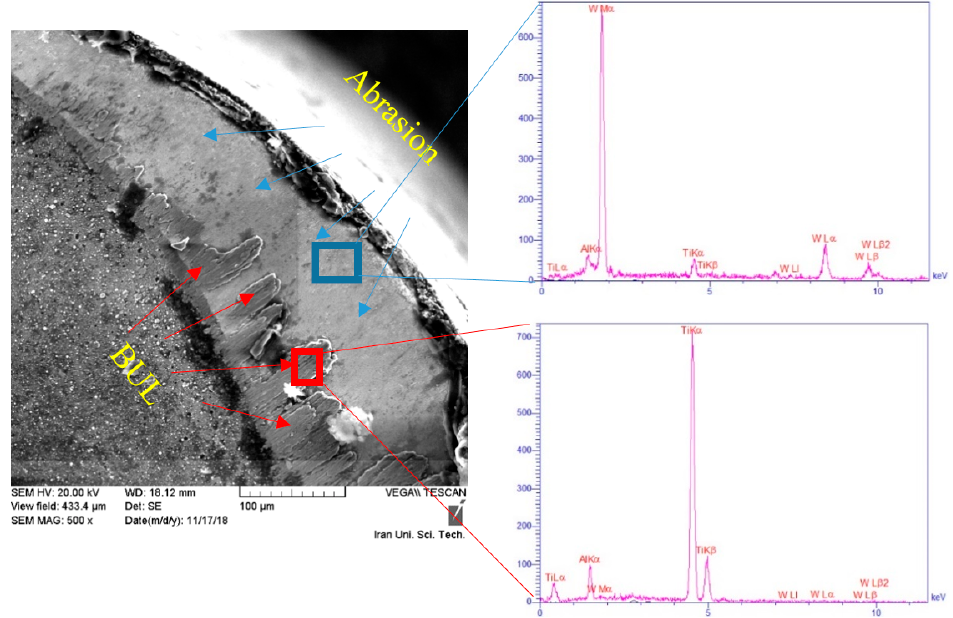
Figure 9. Wear modes on the rake face of insert TS2000 after 120 s of cutting.